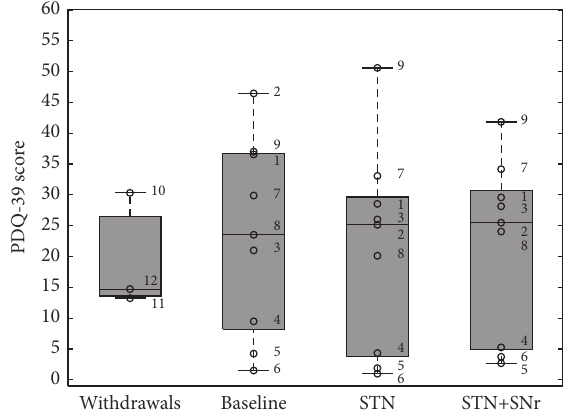
Figure 7: Boxplots of QUIP-RS scores: the box plot depicted on the leftrepresentsthebaselinevaluesofthethreepatientswhowithdrew. The other three box plots represent the values of the 9 PD patients who have completed the study at the three visits: (1) baseline, (2) STN alone, and (3) combined STN+SNr-DBS. The numbered circles represent the single patients as listed in Table 1. A cut-off for the total QUIP-RS score is not available.